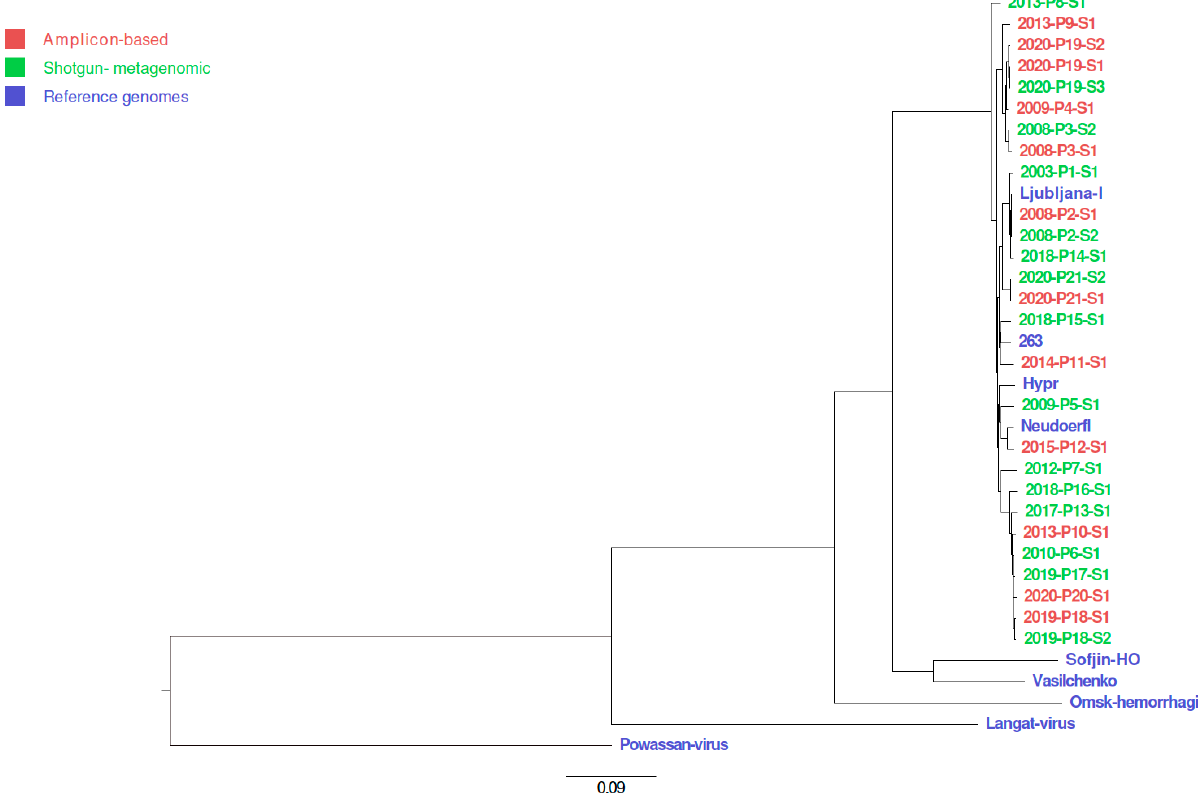
Figure 4. The phylogenetic analysis of generated TBEV consensus sequences. All TBEV genome sequences generated in this study belong to TBEV-Eu subtype. TBEV genome sequences generated from the same clinical sample but with different approaches or sequenced with different platforms cluster together.